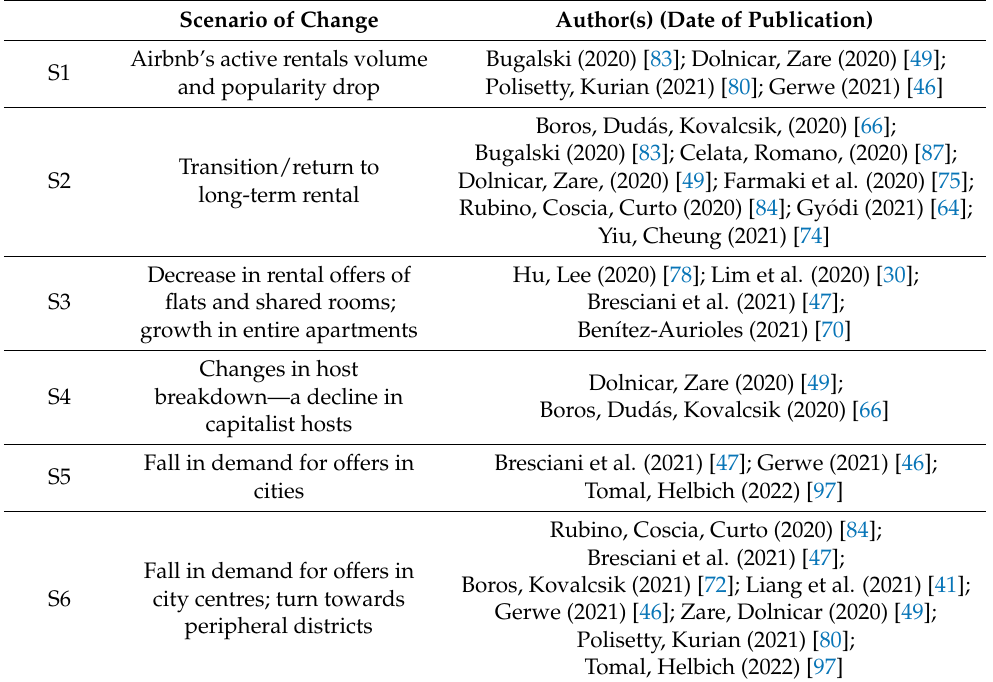
Table 1. Main possible scenarios for COVID-19-induced changes in Airbnb (STRs) featured in the